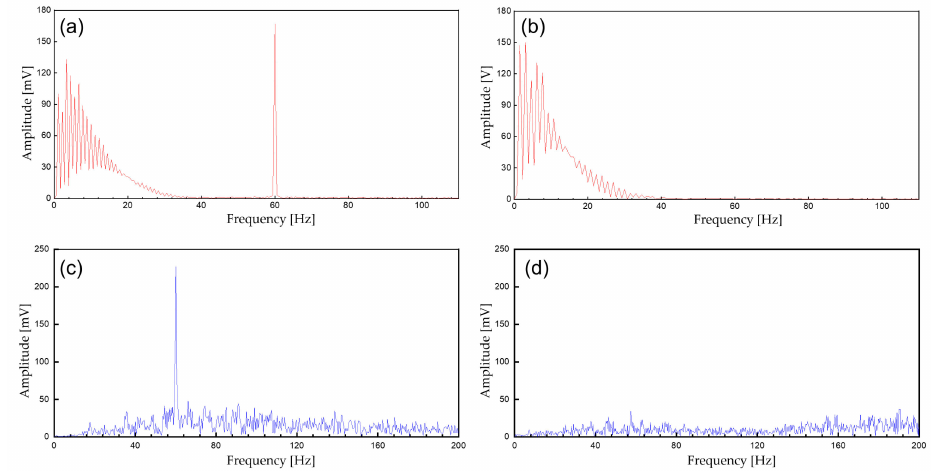
Figure 9. The spectrum of the biopotential signal. ( a ) Unfiltered ECG signals; ( b ) filtered ECG signals (analog notch and digital IIR filter); ( c ) unfiltered EMG; ( d ) filtered EMG signals (analog notch and digital IIR